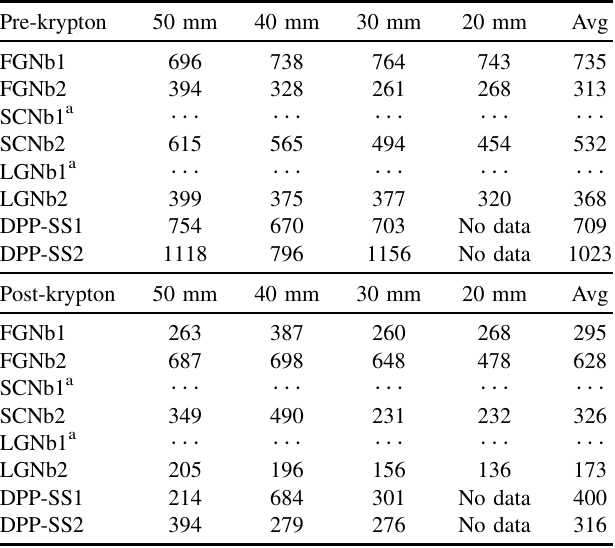
TABLE II. (cid:1) values for all eight electrodes, before and after krypton processing.